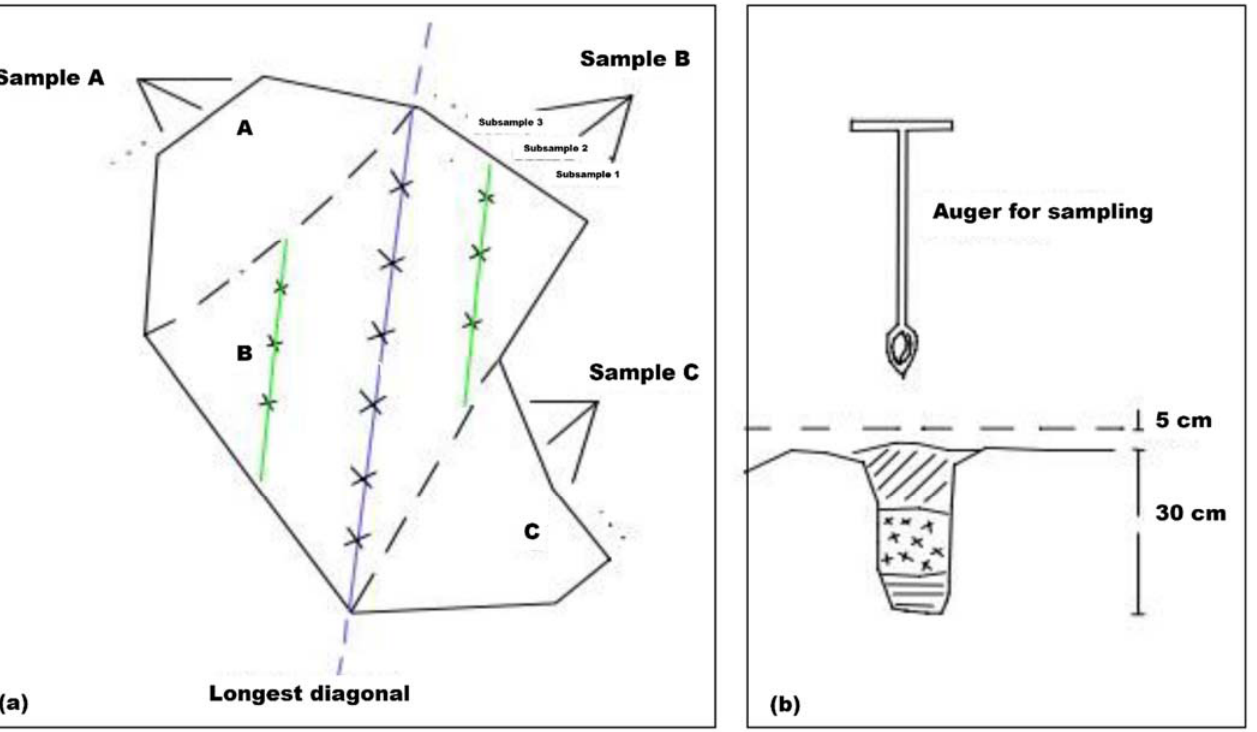
Figure 2. Sampling scheme ( a ) and depth profile ( b ) for the quantification of Verticillium dahliae in the soil on plots where olive orchards were to be planted: each sample should be representative of a homogeneous surface for the type of soil, type of cultivation, or type of cultural practices and not greater than 2–2.5 ha. If the homogeneous plot was larger or had different types of soil or crop rotations, it was divided into smaller sampling units. In this way, the initial plot was divided into several subplots (A, B, C, etc.), from which a sample was obtained: sample A, sample B, sample C, etc. Each of the samples was in turn composed of different subsamples (1, 2, 3, etc.) that had to be taken every 10-20 m (green lines) on the longest diagonal (purple line) of each of the subplots.